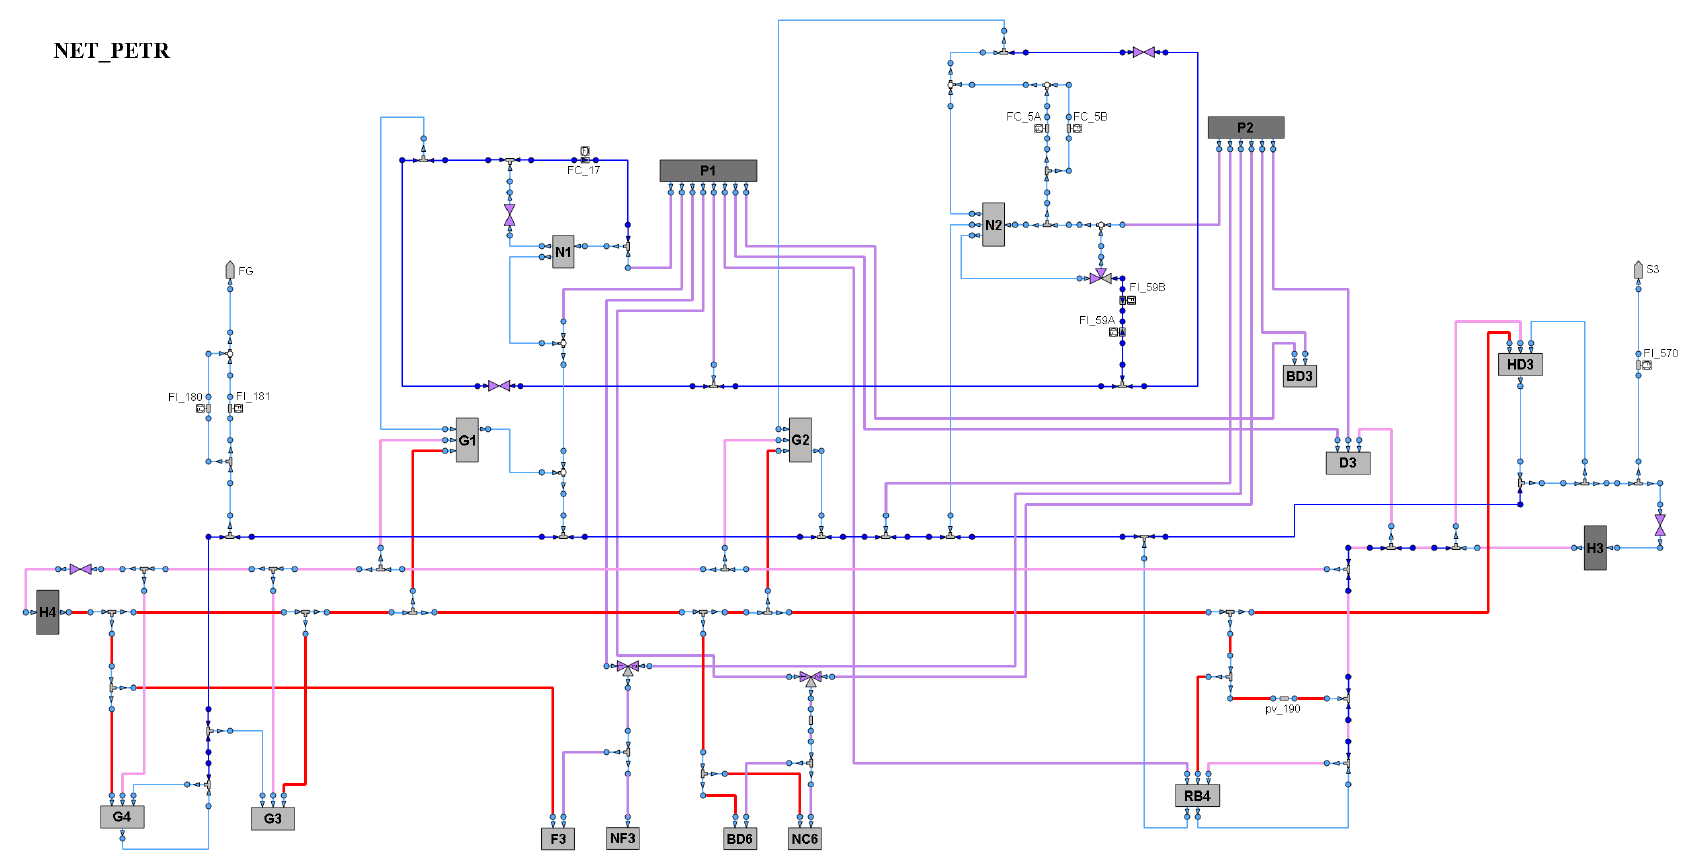
Figure 1. Schematic of the hydrogen network of the Petronor refinery. Dark grey boxes represent producer plants, while light grey ones refer to hydrogen consumer units.